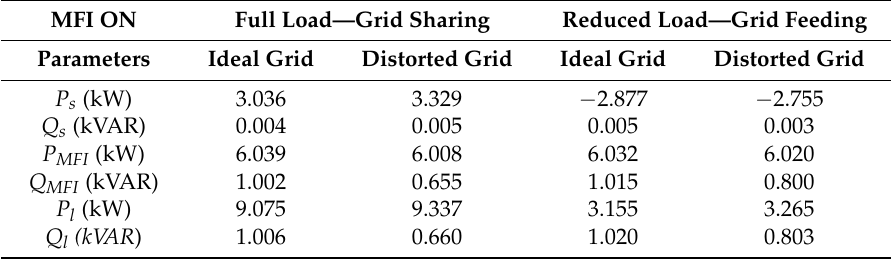
Table 6. Active and reactive power summary under ideal and distorted grid conditions under Ir = 1000 W/m 2 .